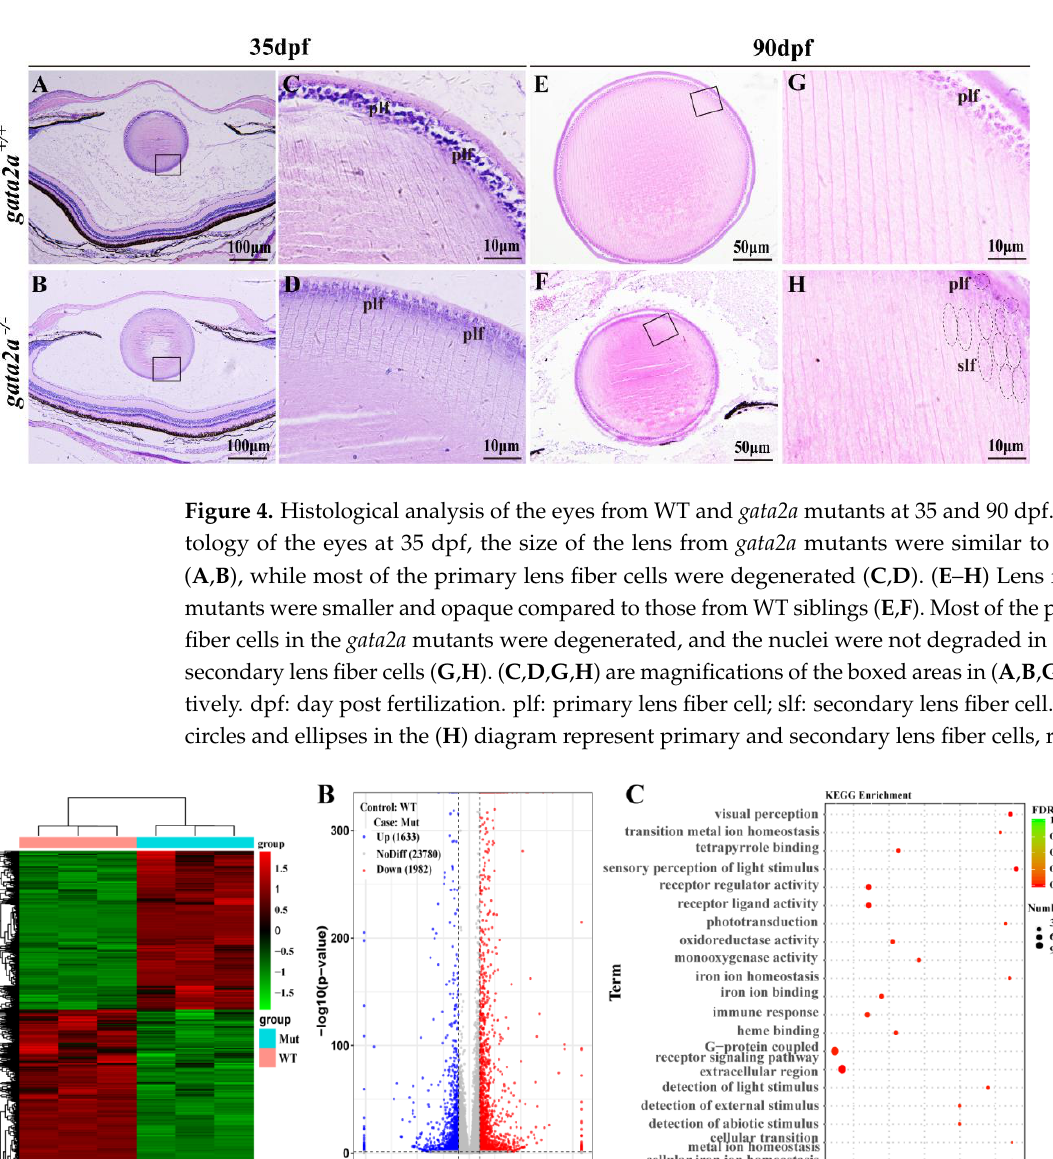
Figure 5. Comparative transcriptomic analysis of genes and molecular pathways dysregulated in gata2a −/− eyes. ( A ) Heatmap displaying difference in gene expression between eyes from WT ( gata2a +/+ ) and gata2a mutants ( gata2a −/− ) at 35 dpf. ( B ) Volcanic map of differentially expressed genes (DEGs) between the eyes from WT and gata2a mutants. A total of 1982 and 1633 genes were down- regulated and upregulated, respectively, in the eyes from gata2a mutants compared with the eyes from WT fish. ( C ) Scatter plot of the enriched KEGG pathways for the DEGs. The sizes and colors of the dots represent the number of genes and the significance of the difference, respectively. ( D ) Effects of gata2a mutation on gene expression of the gata family. ( E , F ) Gata2a mutation down-regu- lated crystallin family genes ( E ), and up-regulated visual perception and iron ion binding-related genes ( F ) in the eyes. Data were presented as the mean ± SD of triplicates. Differences between groups were statistically examined with two- tailed unpaired Student’s t -test. Significant difference is denoted by * ( p < 0.01) and ** ( p < 0.001). 3. Discussion In the present study, we demonstrated that Gata2a expression began in the fiber cell mass of the developing lens, and continued to be expressed in primary and secondary fiber cells throughout lens development. Consistent with its spatiotemporal expression in the developing lens, the absence of gata2a led to the death of primary fiber cells, resulting in progressive microphthalmia and blindness. The GATA family of zinc finger domain transcription factors in vertebrates includes six members, GATA1- 6, which all bind to a consensus ‘‘A/T -GATA- A/G’’ DNA motif [30]. GATA factors are important for the development of several organs controlling prolifera- tion, differentiation and movement, as well as cell-fate specification [20]. Among the six GATA members, GATA2 is the most widely studied because of its important role in the hematopoietic system. Teleost fish have undergone a third whole genome duplication (3R) specific to their lineage, resulting in the retention of multiple gene paralogs. How- ever, only Gata2 of the six members retains two paralogons in teleosts [2]. In tongue sole ( Cynoglossus semilaevis ) and Japanese flounder ( Paralichthys olivaceus ), selection pressure analysis predicted that these gene duplicates experienced purification selection and pos- sible neo-functionalization [2]. In this study, we found that gata2a plays an important role in lens morphogenesis, which has not been previously reported. A study in mice showed